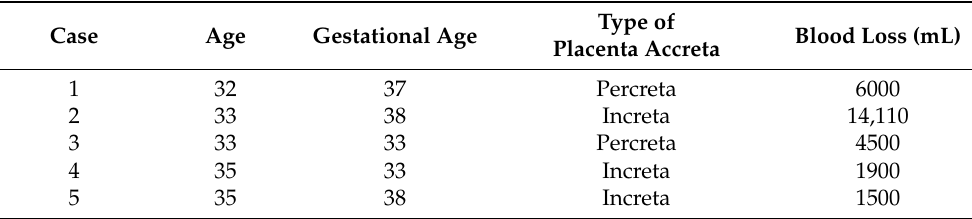
Table 2. Clinical characteristics of the subjects with placenta accreta complications. All PAS subjects underwent hysterectomy after delivery.